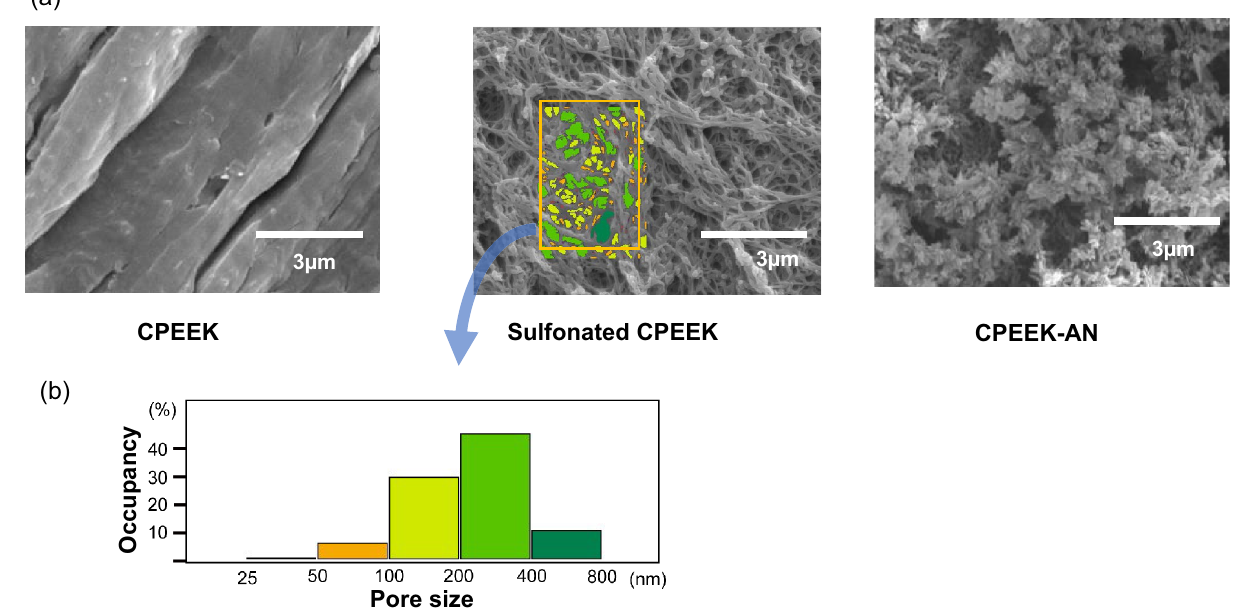
Figure 3. ( a ) SEM photographs showing the surface of CPEEK, sulfonated PEEK, and CPEEK-AN. ( b ) Characterization of pores formed on the sulfonated week 4, CPEEK-AN in week 4, CPEEK in week 8, and CPEEK-AN in week 8) were 3.25 ± 2.3N, 12.5 ± 6.1 N, 3.13 ± 2.0 N, and 28.7 ± 7.3 N, respectively. Four weeks after implantation, the AN-treatment significantly im- proved the bonding strength of the CPEEK. Furthermore, the strength of CPEEK-AN improved significantly between 4 and 8 weeks, whereas that of CPEEK was insignificant during this term. Radiological evaluation with μ‑CT. New bone, defined as the bone in the intramedullary area within 1 mm width from the surface of the base material, was assessed with µ-CT (Fig. 5e,f). Bone volume/total volume (BV/ TV) and consolidation indicators, including bone mineral density (BMD), trabecular thickness (Trab.Th), and bone surface/bone volume (BS/BV), were calculated. Trab.Th was thicker with decreased BS/BV (Fig. S2). At 4 weeks, BV/TV for CPEEK-AN was significantly higher than that for CPEEK (CPEEK 20.3 ± 5.2 N, CPEEK- AN 30.6 ± 9.9 N); however, other consolidation indicators showed no significant difference between the two (Fig. 5g–j). Interestingly, BV/TV at 8 weeks for both substrates decreased as time passed (Fig. 5g); however, the value for CPEEK-AN was still higher than that for CPEEK (CPEEK 12.9 ± 4.1 N, CPEEK-AN 22.8 ± 8.0 N). In contrast, other consolidation indicators for CPEEK-AN improved at 8 weeks, and BMD and Trab.Th with and without treatments showed a significant difference. Histological evaluation. Four slices from each extracted block were used to assess the bone-implant contact (BIC) ratio determined by the contact between bone and substrates (Fig. 5k,l). BIC ratios were approximately the same at 4 weeks for both groups, as shown in Fig. 5m. In contrast, at 8 weeks, the BIC ratio of CPEEK changed significantly, and that of CPEEK-AN was unchanged. The interfacial evaluation between new bone and substrates. µ-CT images and the almost corresponding histo- logical images were prepared for overall evaluation of the interface between the bone and each substrate (Fig. 6). At 4 weeks, both CPEEK and CPEEK-AN formed woven bone. However, CPEEK-AN exhibited more woven bone far from substrates than CPEEK. At 8 weeks, the woven bone for CPEEK-AN matured, whereas that for CPEEK disappeared. To further understand whether integration had been achieved, the images with three devices (μ-CT, histological assessment, and SEM) were obtained with higher magnification, showing different insights into the bone-implant interfaces (Fig. 7a,b). Under high magnification with SEM, we observed a gap of < 10 µm, caused by the absence of integration, in the sample for CPEEK (Fig. 7c); however, this gap was absent for CPEEK-AN (Fig. 7d). Energy-dispersive X-ray (EDX) analysis showed two patterns of this gap implying the absence of integration. One is the gap with no Ca or P, and the other is the layer with properties of carbon, Ca, and P seen as a residual apatite nuclear or supposedly middle progress during ossification (Fig. 7c). “Conversely, the line analysis (Fig. 7e) suggested that no clear gap was observed between CPEEK and newly formed bone”. Tartrate‑resistant acid phosphatase (TRAP) and alkaline phosphatase staining (ALP) co‑staining assay for new bones. The presence of TRAP-positive cells indicated that bone resorption was proceeding. Newly formed bone on CPEEK-AN 4 weeks after implantation, which was partly stained with ALP, possessed osteocytes in